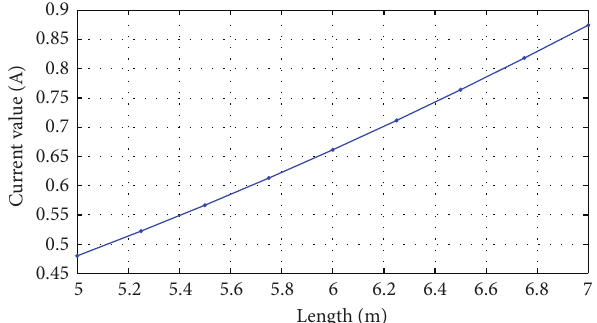
Figure 10: Curve of the maximum current value with the antenna length.